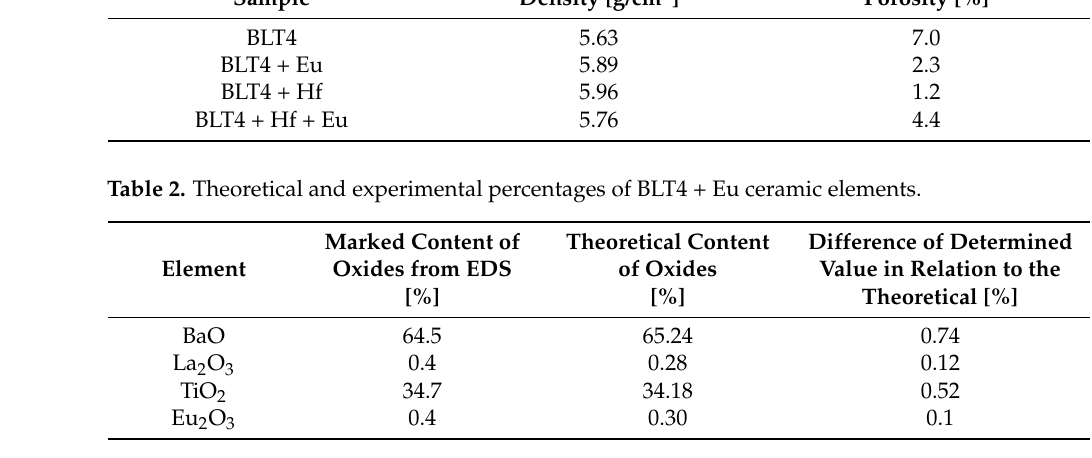
Table 3. Theoretical and experimental percentages of BLT4 + Hf ceramic elements.